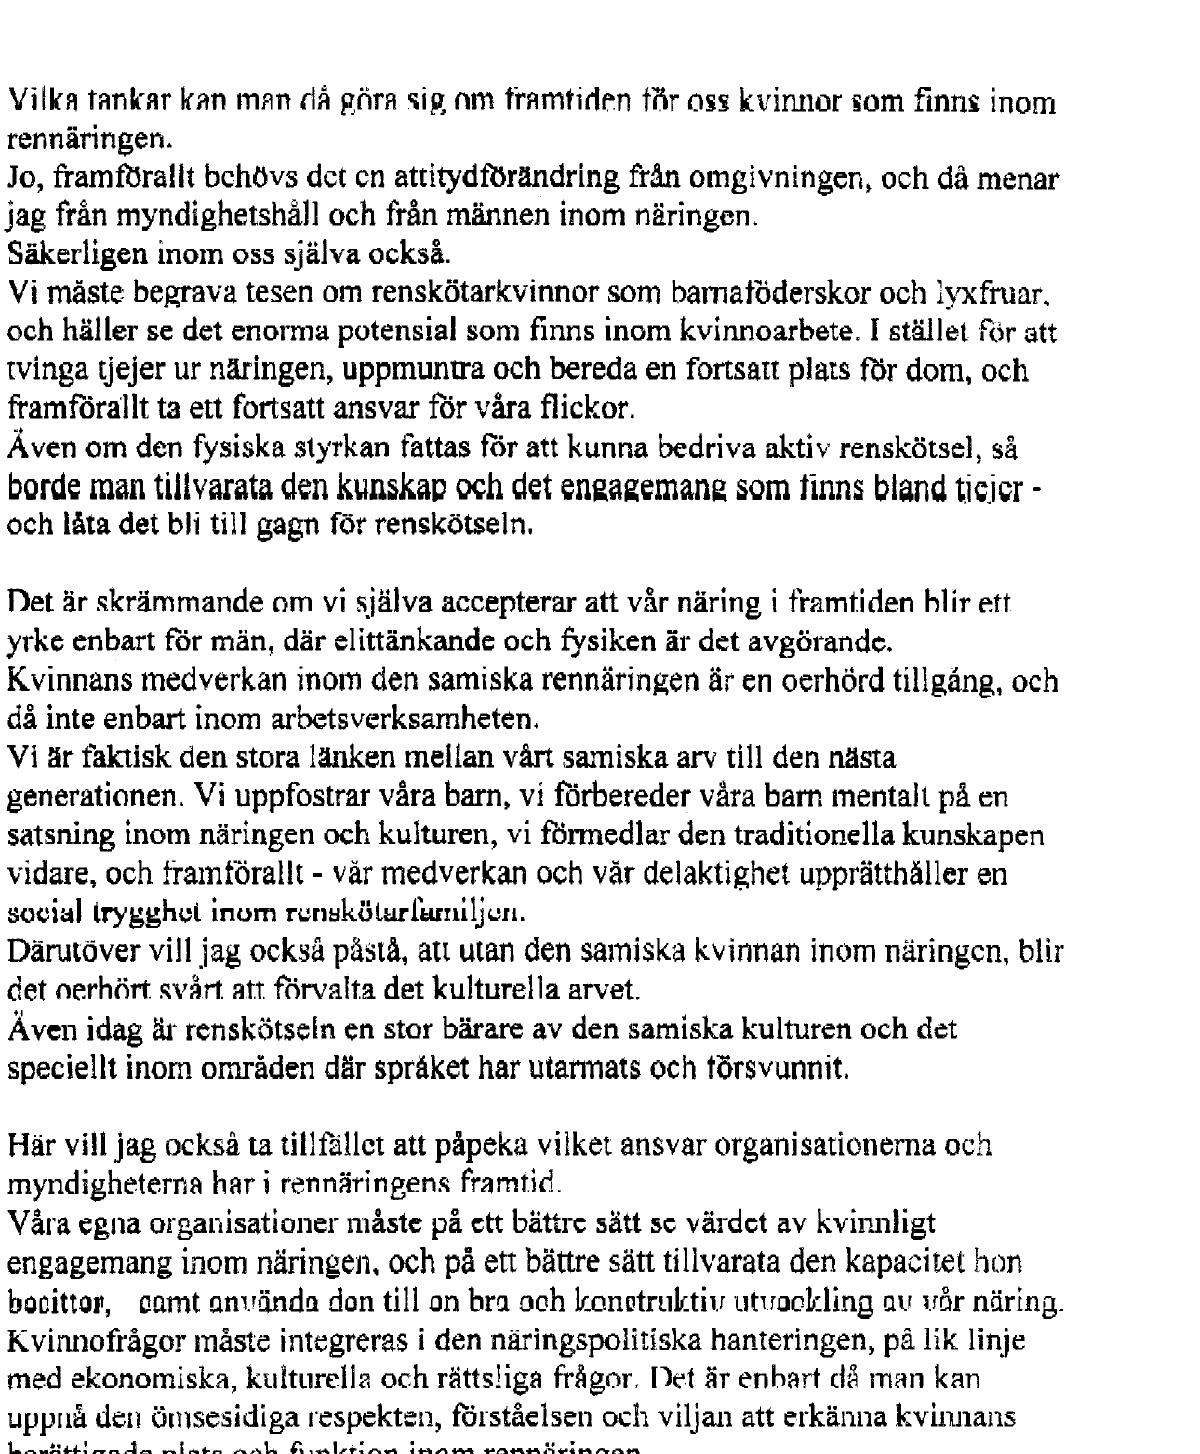
Vilta tankar km man rlå ghra sig nm framtiden tflr oss kvinnor som finns inom